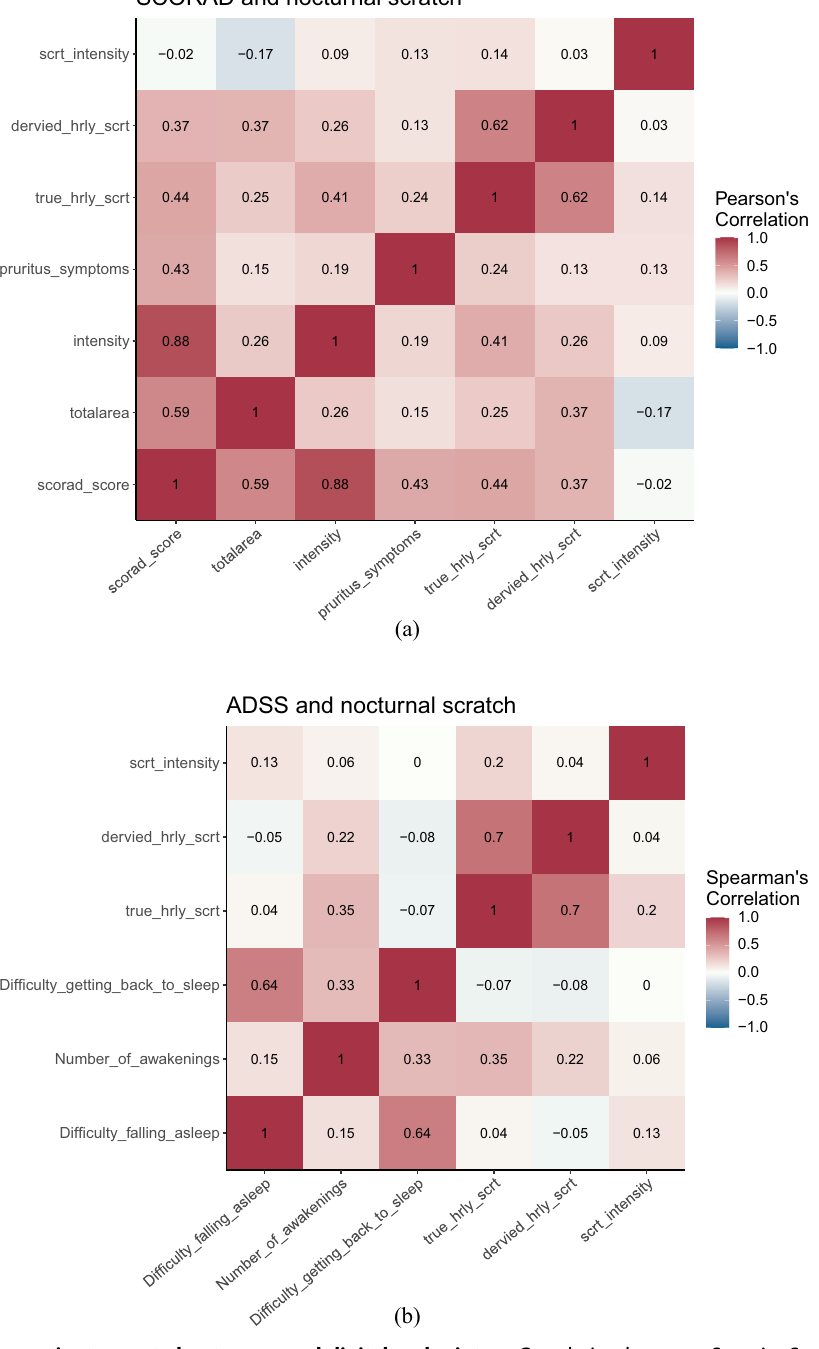
Fig. 4 Correlation between patient-reported outcomes and digital endpoints. a Correlation between Severity Scoring of Atopic Dermatitis Index (SCORAD) and scratch duration. b Correlation between Atopic Dermatitis Sleep Scale (ADSS) and scratch duration. Table 4. Intraclass correlation